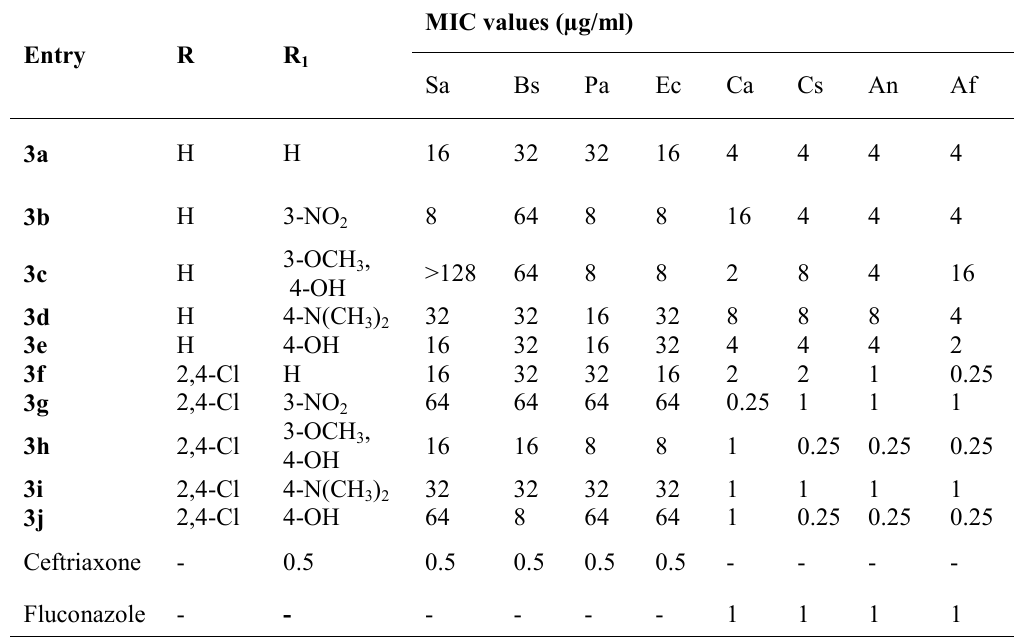
Table 3. In-vitro antimicrobial activity of compounds (3a-j)